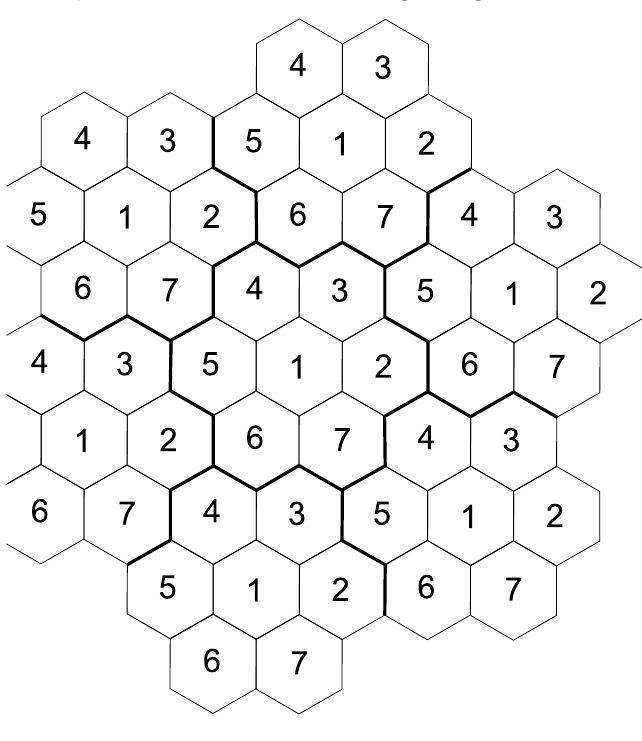
Figure 11 . Several tiles arranged